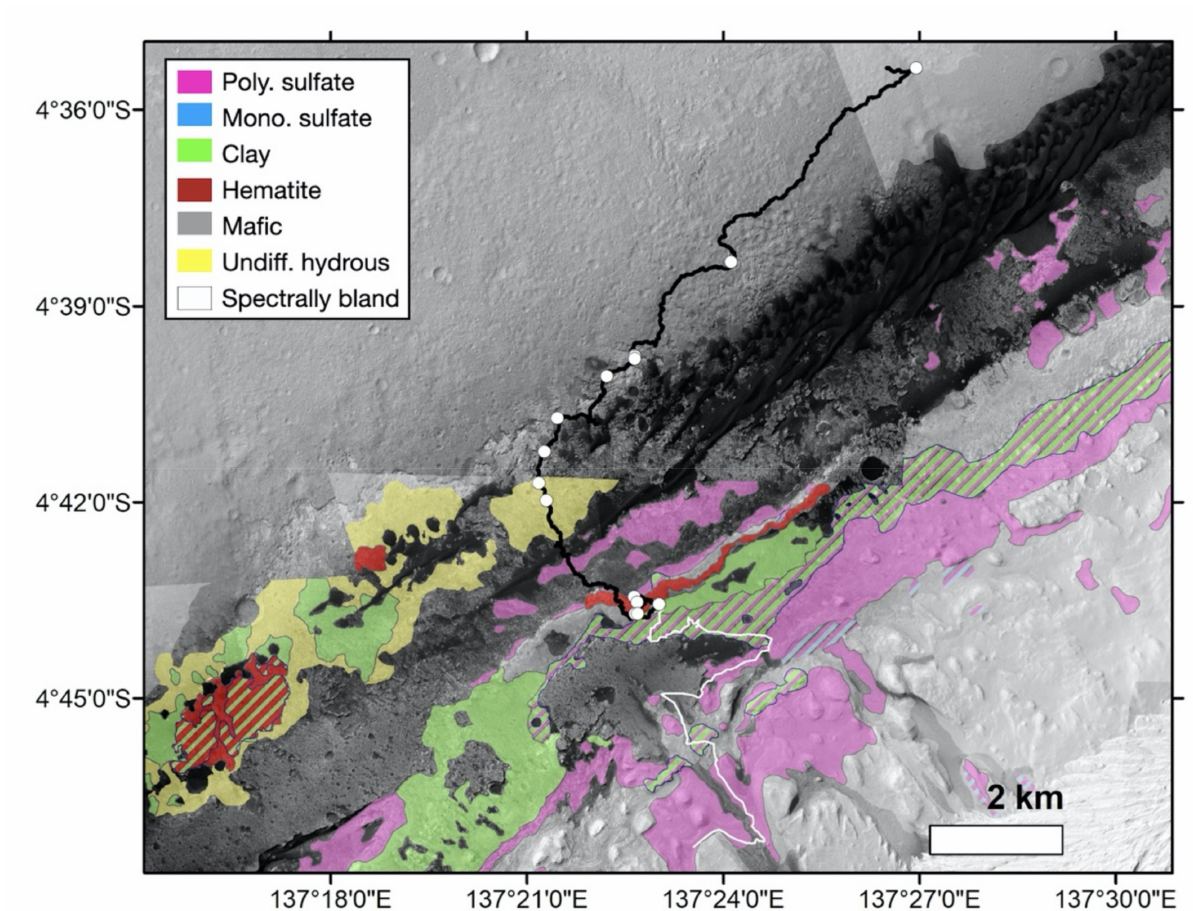
Figure 3. Orbital mineralogy of northwest Mount Sharp based on [26] and hematite detections from [28]. The rover traverse route through sol 2390 (black line) and subsequent planned route (white line) are shown. White circles show drill hole locations through sol